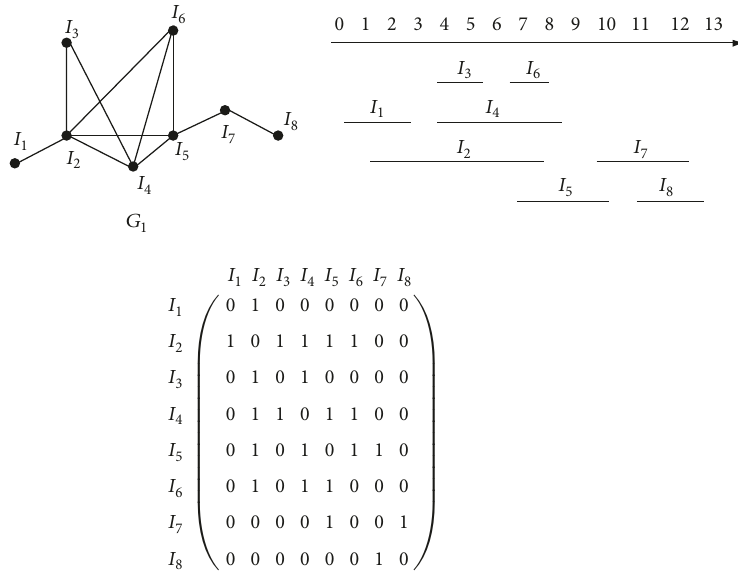
Figure 2: A weighted interval graph 𝐺 1 with weights 𝑤(𝐼 1 ) = 1 , 𝑤(𝐼 2 ) = 3 , 𝑤(𝐼 3 ) = 2 , 𝑤(𝐼 4 ) = 2 , 𝑤(𝐼 5 ) = 1.2 , 𝑤(𝐼 6 ) = 2 , 𝑤(𝐼 7 ) = 2 , 𝑤(𝐼 8 ) = 2 and its associated adjacency matrix, local cuts.